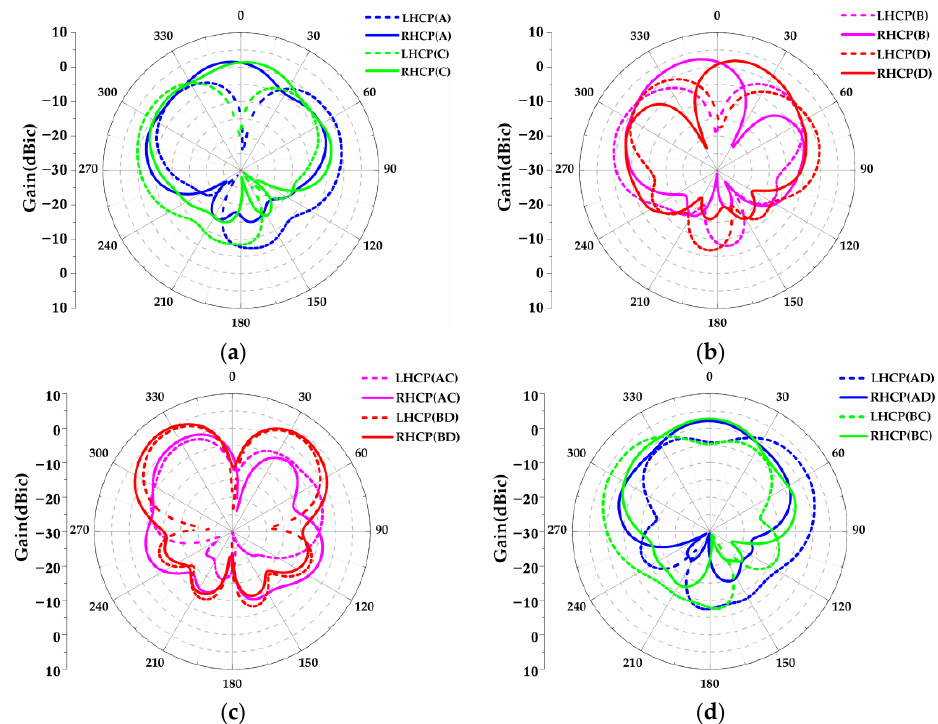
Figure 15. Radiation patterns at 2.4 GHz for different combinations: ( a ) A and C; ( b ) B and D; ( c ) AC and BD; ( d ) AD and BC.